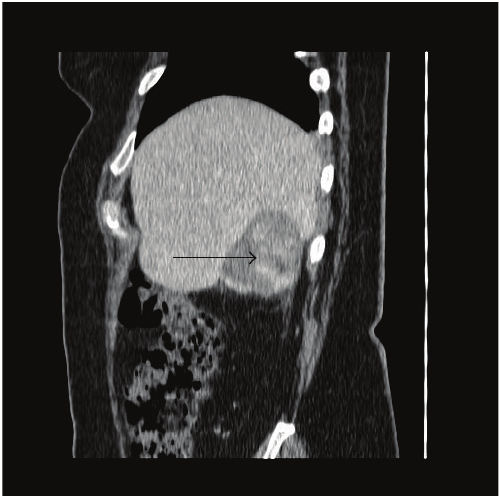
Figure 2: Contrast-enhanced computed tomography of the abdomen in the coronal plane demonstrates intralesional areas of arterial enhancement (arrow). There is a small amount of paracolic gutter fluid.